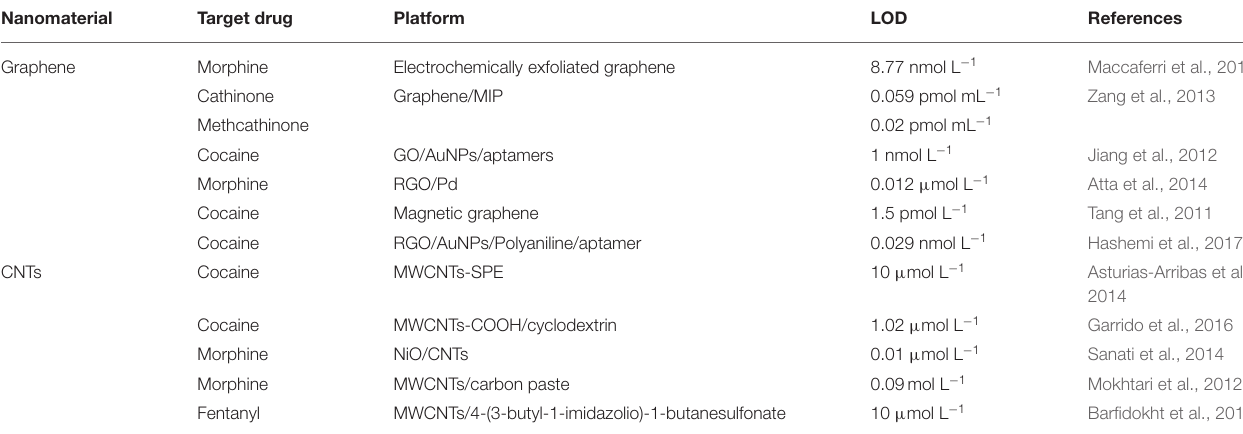
TABLE 3 | Overview of sensors based on graphene and CNTs platforms.